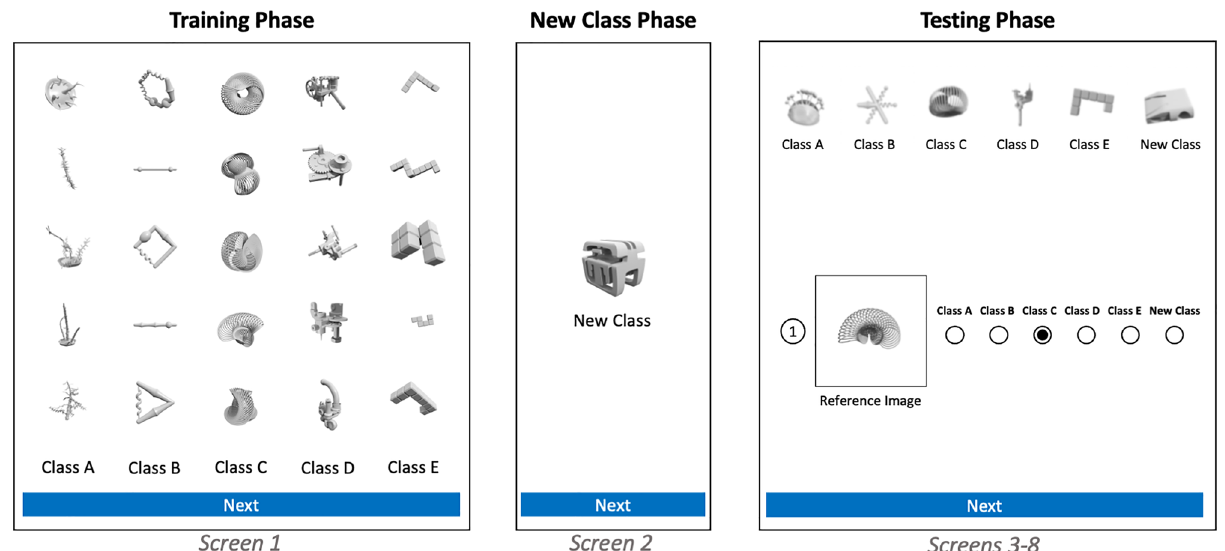
Figure 1. Schematic of our one-shot learning task presented to human participants. At the time of training, participants viewed 5 classes of objects, with 5 examples each. When they progressed to the next screen, they were presented one example of an object from a “new class”. At test time, they viewed 6 consecutive screens with examples from each of the classes, and were asked to categorize to which class they